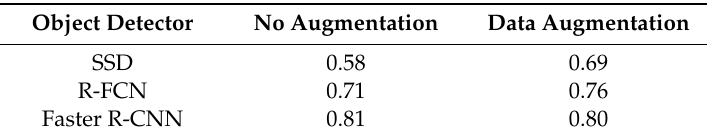
Table 5. Comparison of di ff erent object detectors with and without data augmentation. The metric is MAP@0.5IoU.